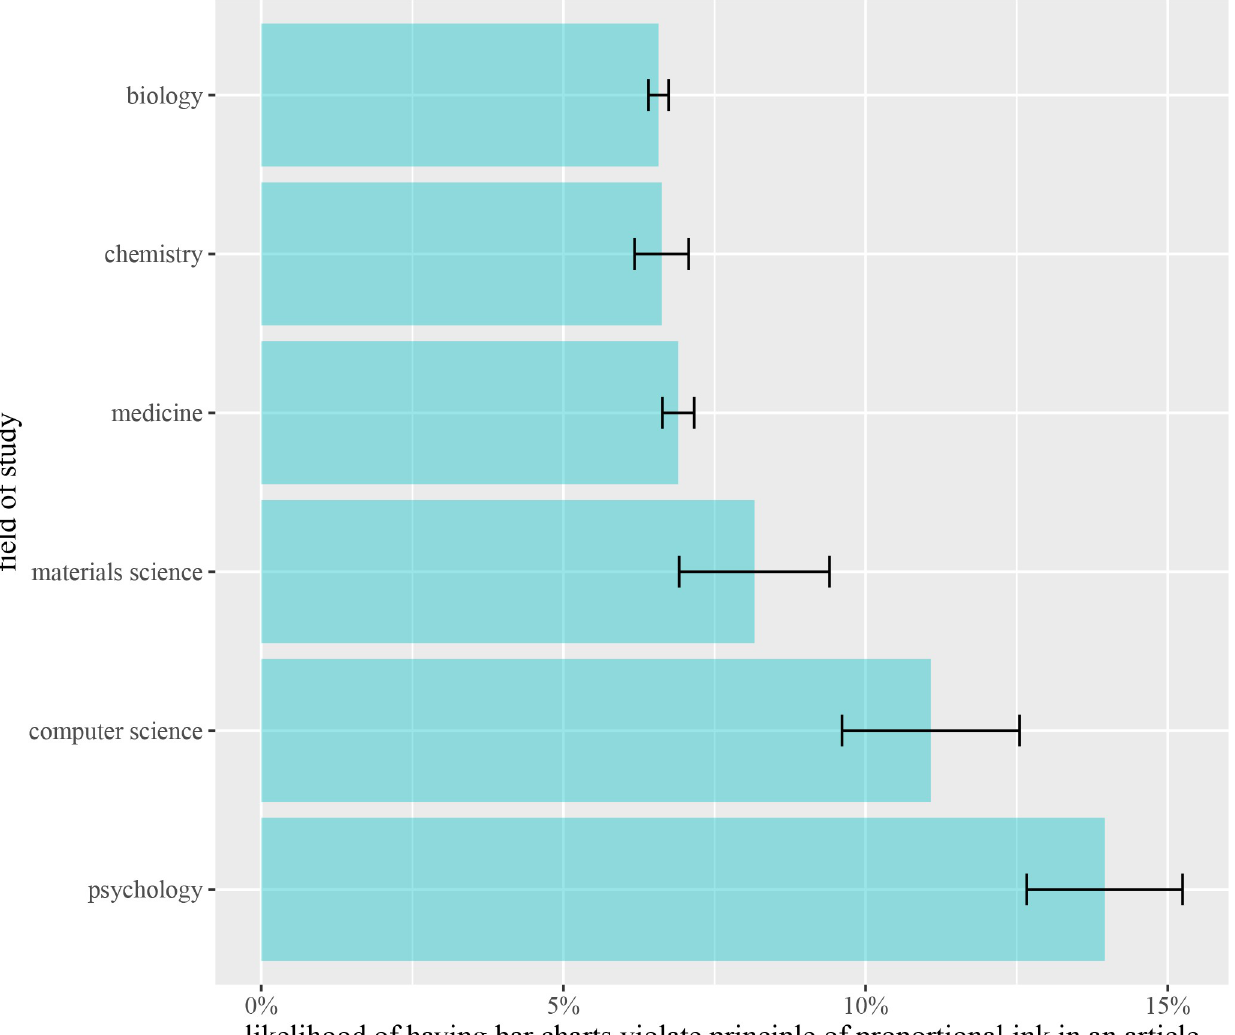
Fig 4. The likelihood of having graphical integrity issues across each research